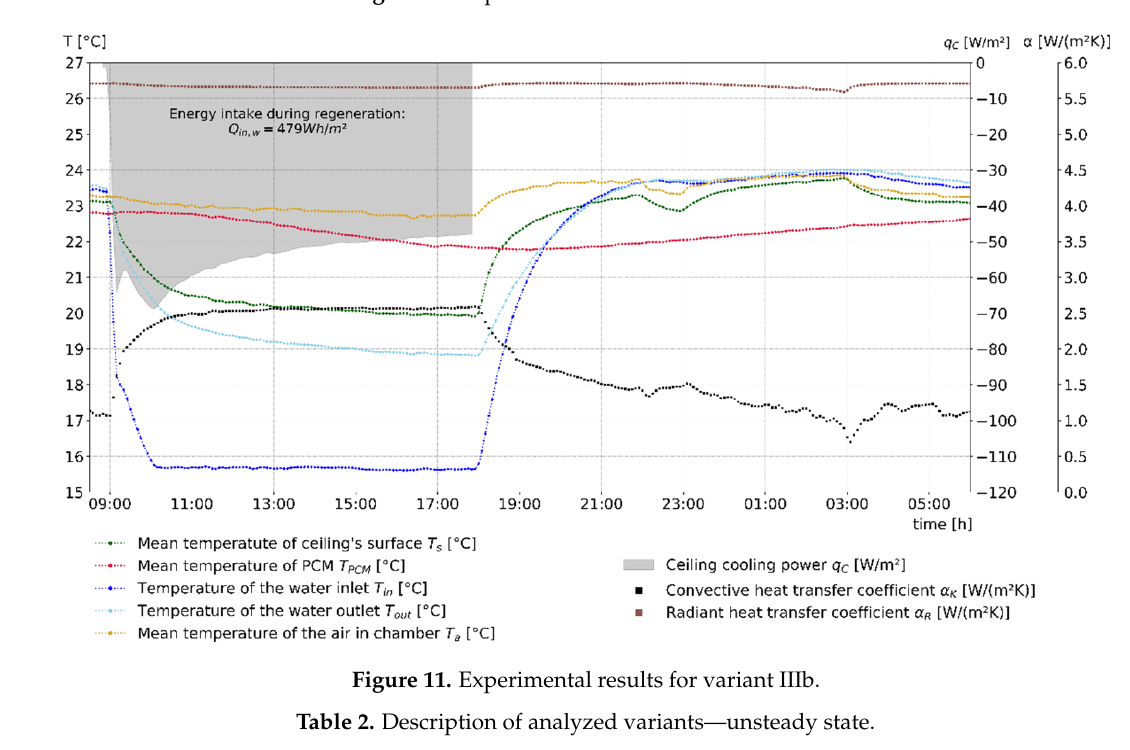
Figure 10. Experimental results for variant IIIa.